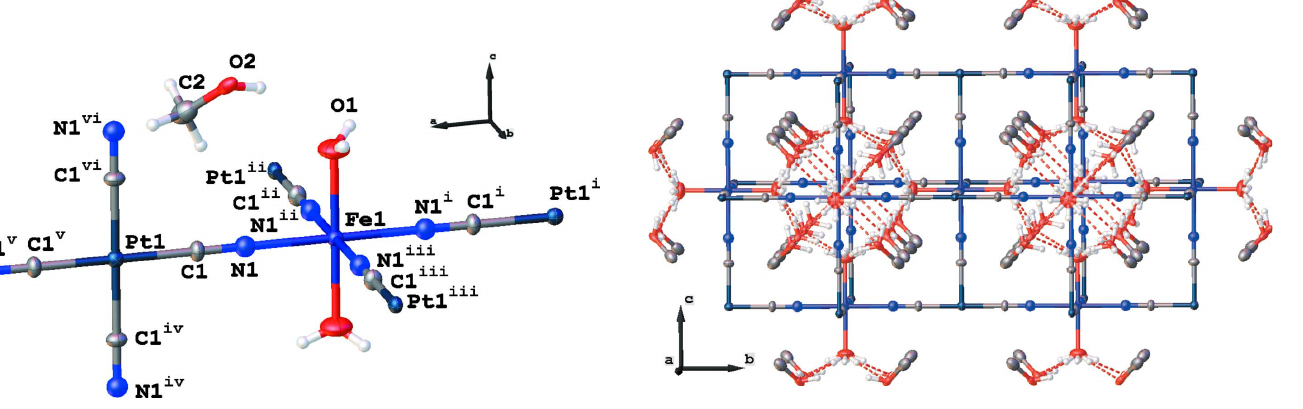
Figure 2 View of the crystal structure of the title compound along the a axis showing the three-dimensional coordination framework. Hydrogen bonds are shown as red dashed lines. Hydrogen atoms of the methyl group of the methanol solvent molecules are omitted for clarity.